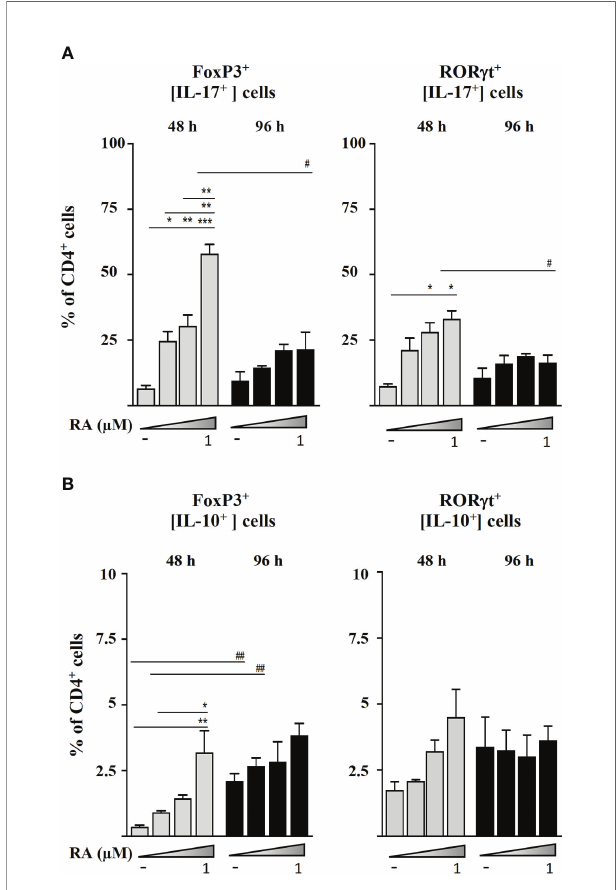
FIGURE 3 | Magnetic sorted CD4 + CD25 - spleen cells from BALB/c mice were stimulated with plate-bound anti-CD3 and soluble anti-CD28 in the presence of IL-2 (20 ng mL -1 ), TGF- b (5 ng mL -1 ), and RA (0.01, 0.1, or 1.0 m M). (A) Intracellular IL-17 expression in Foxp3 + and ROR g t + cells after 48 and 96 h of culture. (B) Intracellular IL-10 expression in Foxp3 + and ROR g t + cells after 48 and 96 h of culture. Data are means of three different experiments (each performed with cells sorted from polled spleens from 3-5 mice) ± SEM (n = 3). * P < 0.05, ** P < 0.01, *** P < 0.001 indicate statistically signi fi cant differences between culture conditions at each time point assessed by one-way ANOVA followed by Tukey post-hoc test, and # P < 0.05, ## P < 0.01 indicate statistically signi fi cant differences between time points for each culture condition assessed by two-way ANOVA followed by Tukey post-hoc